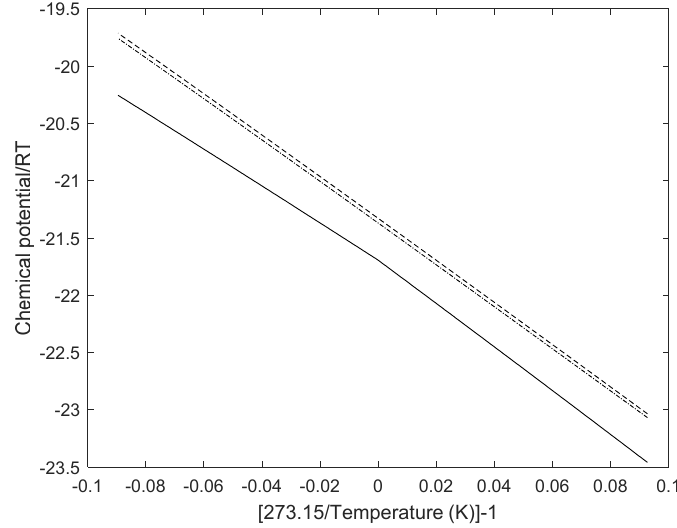
Figure 2. Dimensionless chemical potentials for water in empty clathrate of structure I (dashed), structure II (dash-dot) and water as ice or liquid water (solid).